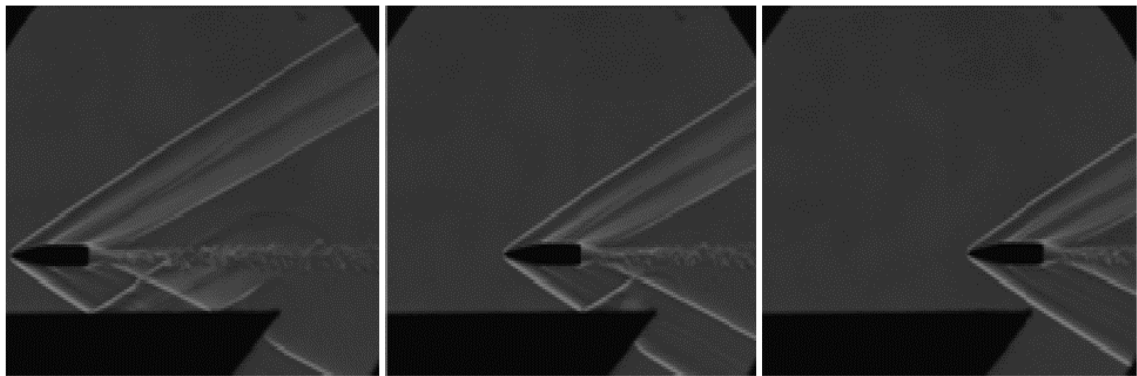
Figure 1: Projectile moving at Mach 2.4 in-ground proximity to a near-wall